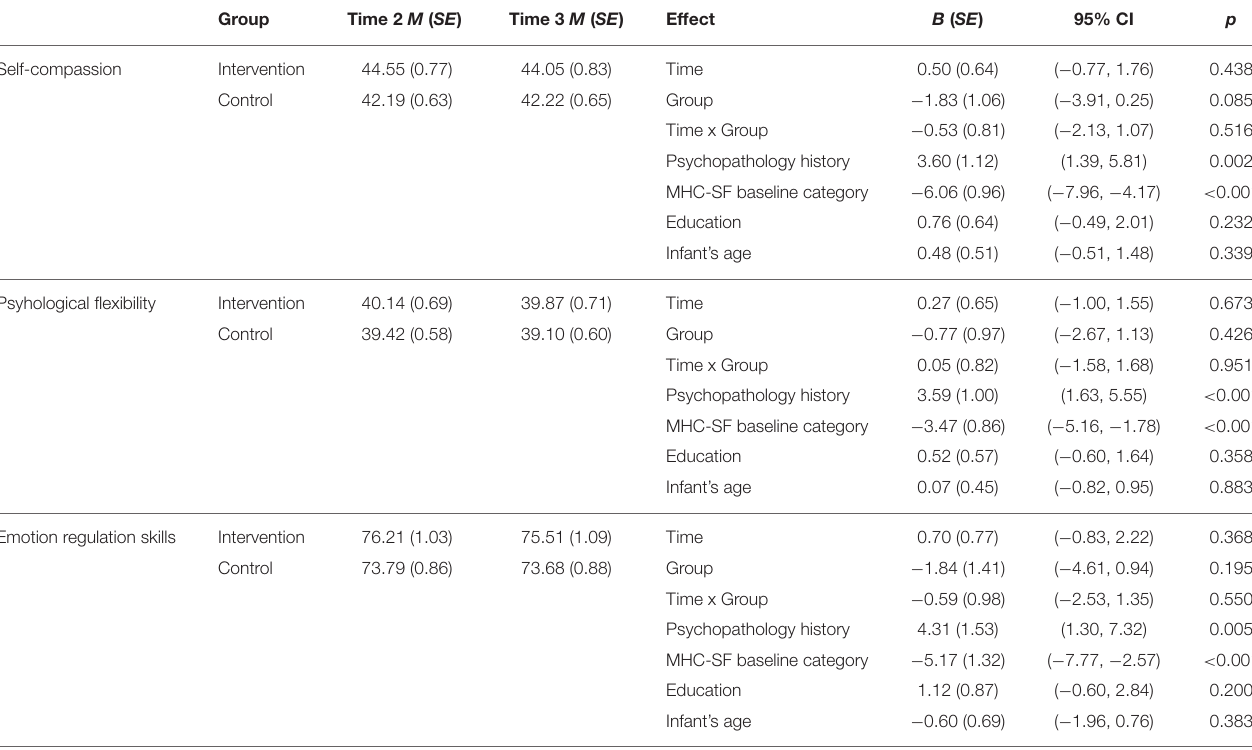
TABLE 3 | Estimated means and fixed effects for psychological processes at 4-months